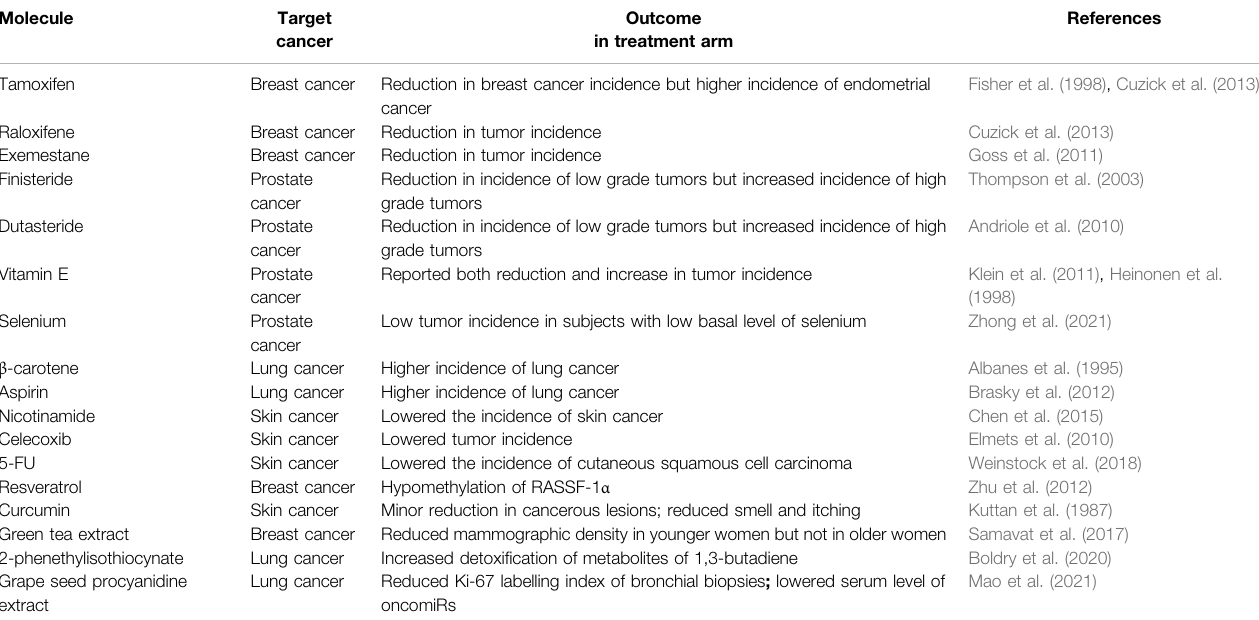
TABLE 2 | Outcome from clinical trials using the phytochemicals as potential chemopreventives.